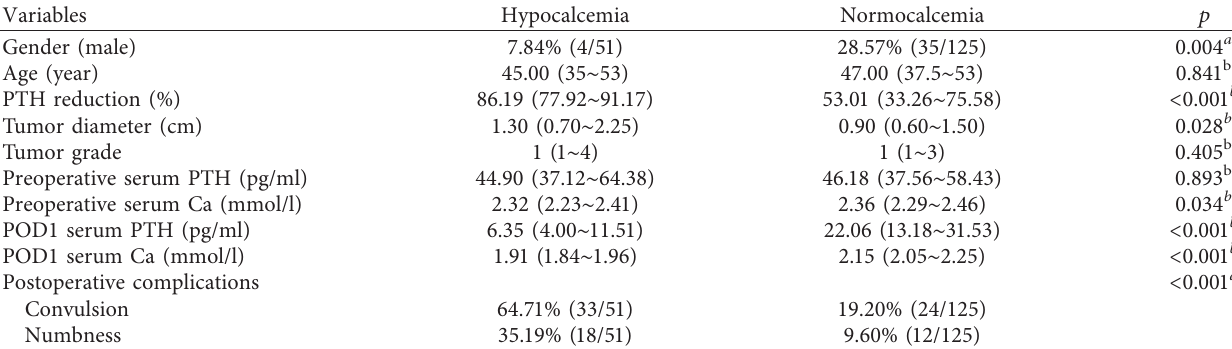
Table 2: The comparison between patients who developed hypocalcemia and normocalcemia on postoperative day 1. Variables